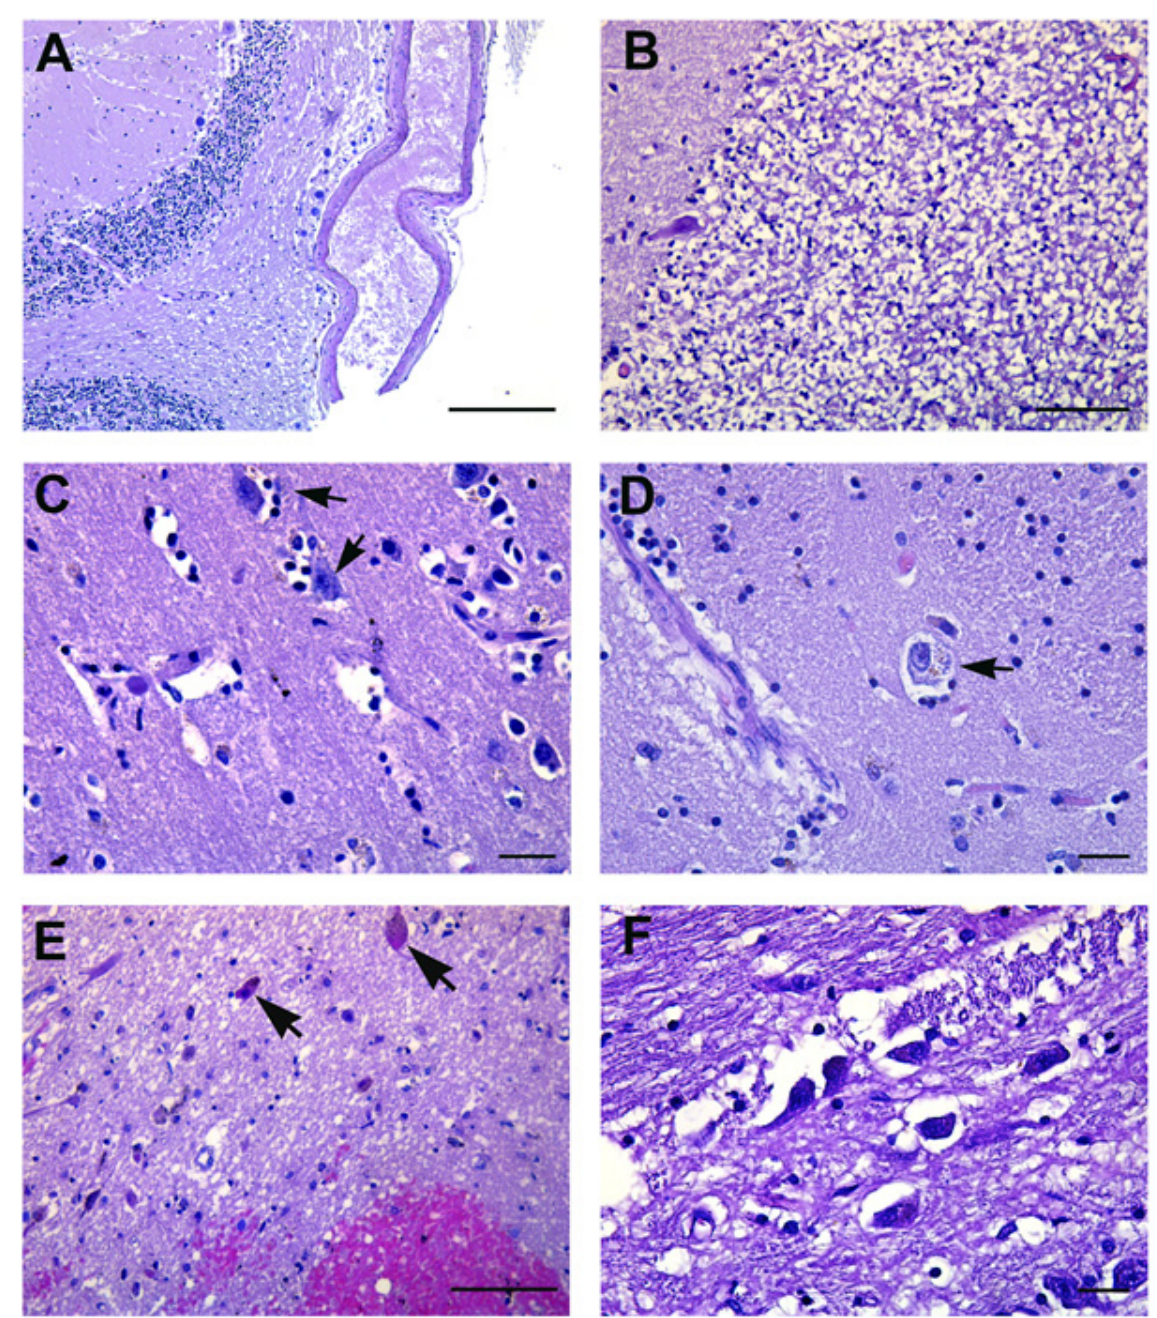
Figure 2. Pathological findings in neurons. ( A ) Cerebellar Purkinje cell layer, showing loss of neurons. ( B ) Disappearance of neurons in the cerebellar internal granular cell layer. ( C , D ) Activated resident glia with varying degrees of neuronal damage (arrows). ( E ) Pons region showing neuronal degeneration represented by small eosinophilic neurons with pyknotic nuclei (arrows). Visible is also hemorrhage around small vessels and reactive gliosis. ( F ) Pons histological section showing gray matter derangement. Images from patients who did not have previous neurological deficits. Scale bars: ( A ) = 100 μ m; ( B , E ) = 50 μ m; ( C , D , F ) = 7 μ m.